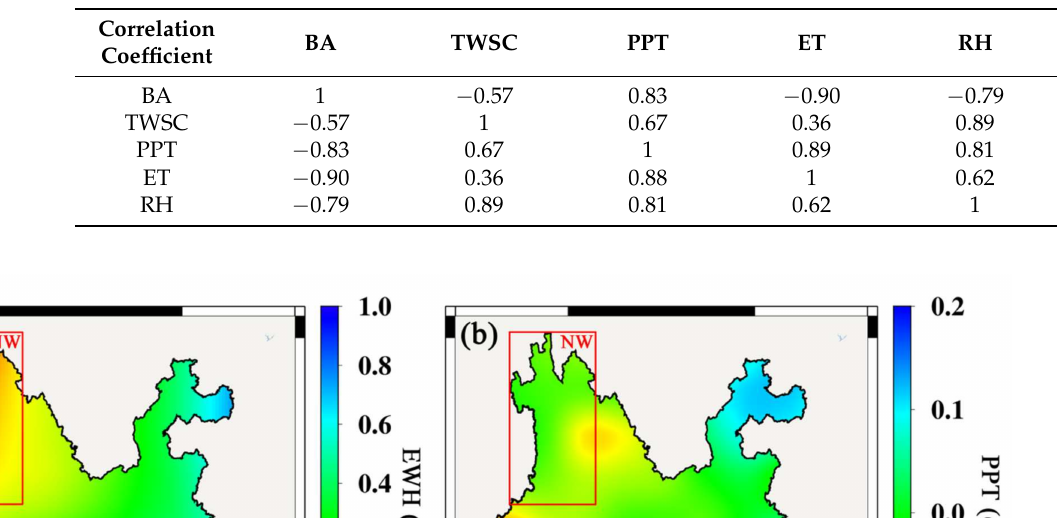
Table 3. The correlation coefficients between burned area (BA), PPT, ET, relative humidity (RH) and TWSC on the seasonal scale in region NW.